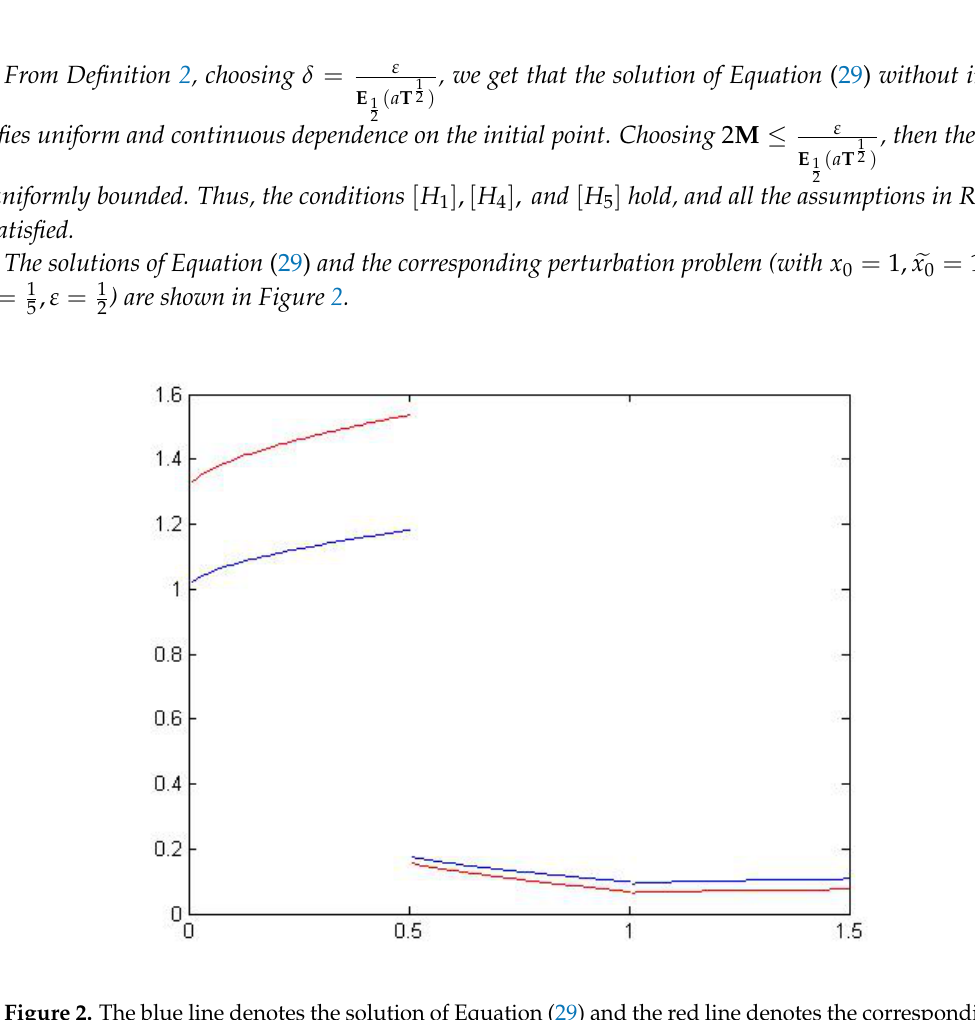
Figure 2. The blue line denotes the solution of Equation (29) and the red line denotes the corresponding perturbation